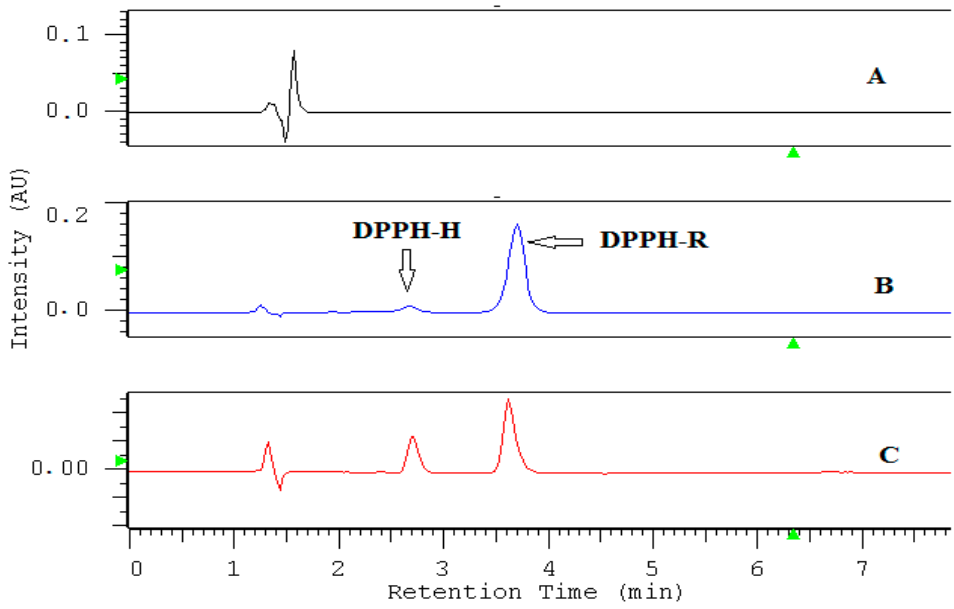
Figure 5. Chromatograms of 0.5 mM of ascorbic acid in 80% ( v / v ) methanol ( A ), 0.35 mM DPPH in methanol ( B ), DPPH reduced with ascorbic acid recorded at 517 nm after 15 min in the dark place ( C ).